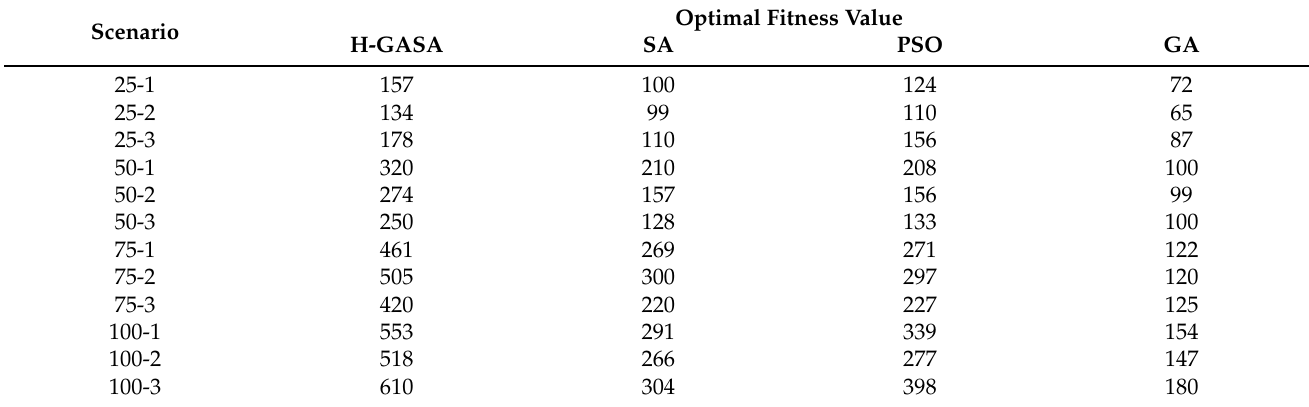
Table 6. Results of fitness value of comparison algorithms with different target